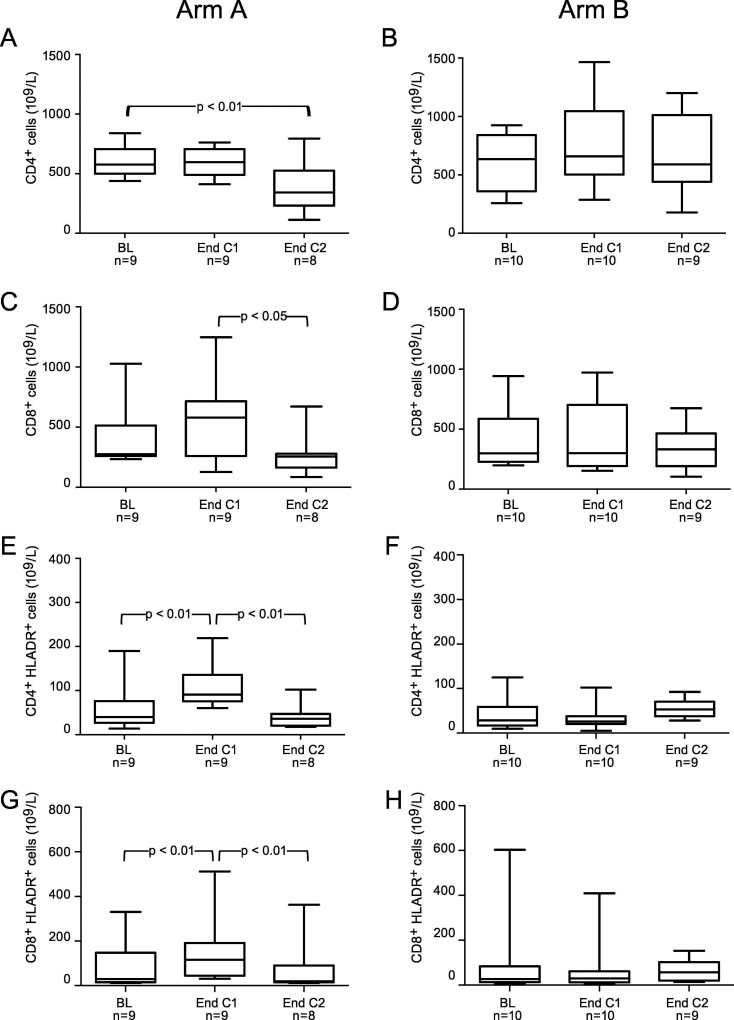
Absolute numbers of subsets of T cells at baseline (BL), at the end of cycle 1 (End C1) and at the end of cycle 2 (End C2) in part II patients treated with either lenalidomide monotherapy during cycle 1 with the addition of gemcitabine from cycle 2 (Arm A) (Left column) (Fig 2 A, C, E and G) or gemcitabine monotherapy during cycle 1 with the addition of lenalidomide from cycle 2 (Arm B) (Right column) (Fig 2 B, D, F and H). Changes in the absolute numbers of CD4+ T cells (A, B), CD8+ T cells (C, D), HLA-DR positive CD+4 T cells (E, F) and HLA-DR positive CD8+ T cells (G, H) over the treatment course, n = number of patients analysed at each time-point. P-values refer to the comparison with BL, End C1 and End C2 by one way ANOVA with repeated measures. The box, with a line indicating median, represents the 25th and 75th percentiles. The top and bottom whiskers represent the 90th and 10th percentiles, respectively.